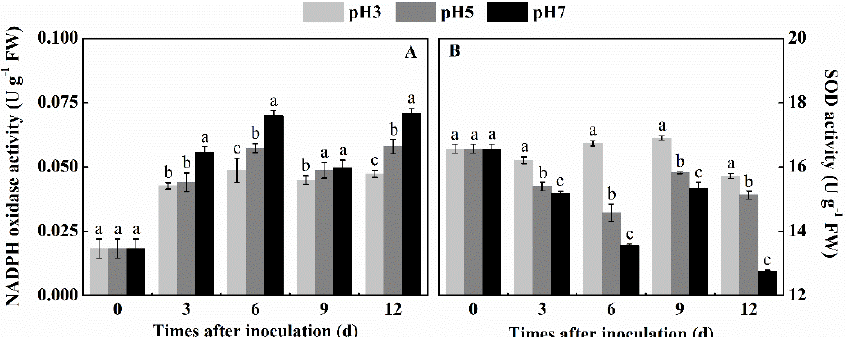
Figure 2. Effect of inoculation of T. roseum at different pH conditions on the activities of NADPH oxidase ( A ) and SOD ( B ) of colonized apple fruits. Bars indicate standard error ( ± SE). Different letters indicate statistically significant differences ( p < 0.05) among treatments.